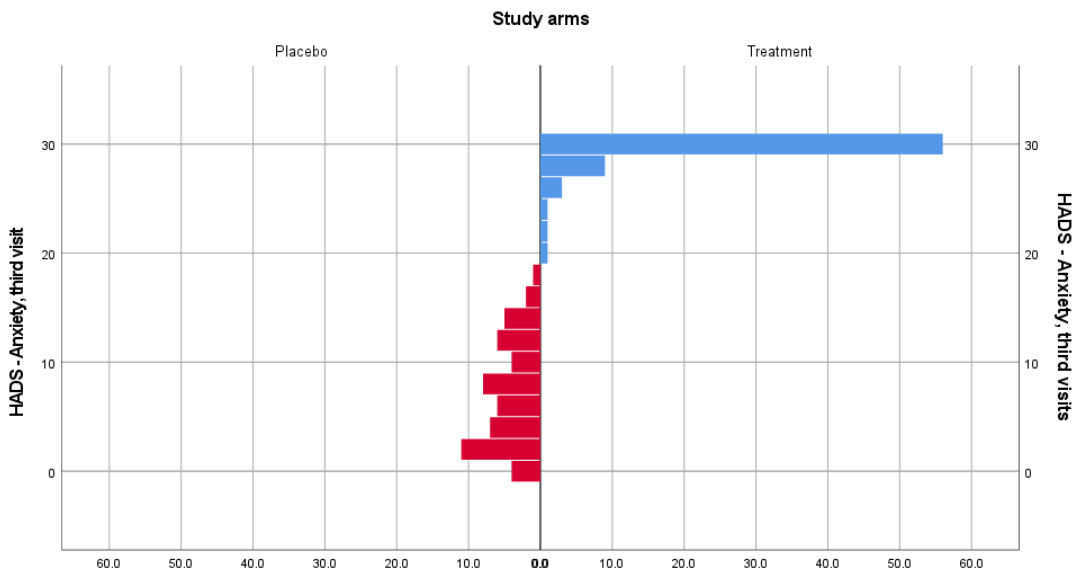
Figure 2. HADS-Anxiety score distribution for the treatment and placebo groups for the third visit. For the HADS depression subscale, the distributions of scores were similar. Median